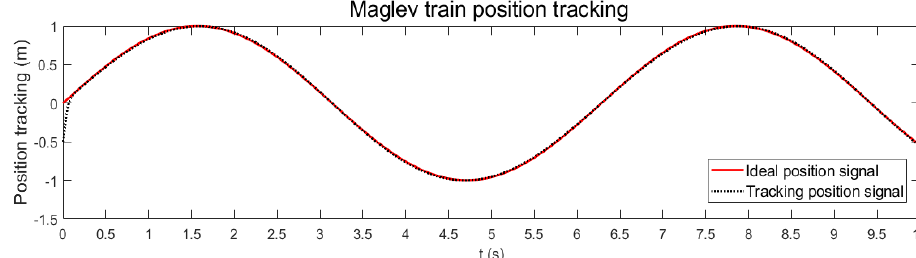
Figure 13. Output error curve.